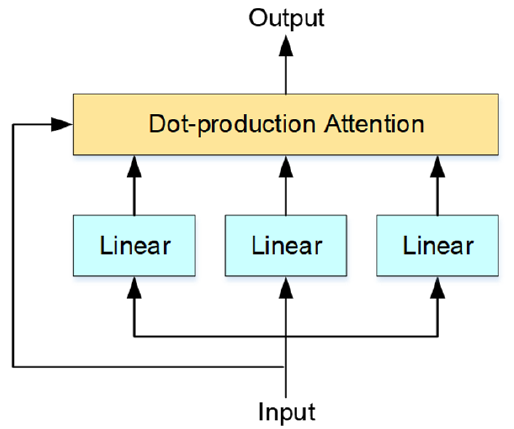
Figure 2. Block diagram of the self-attention mechanism.